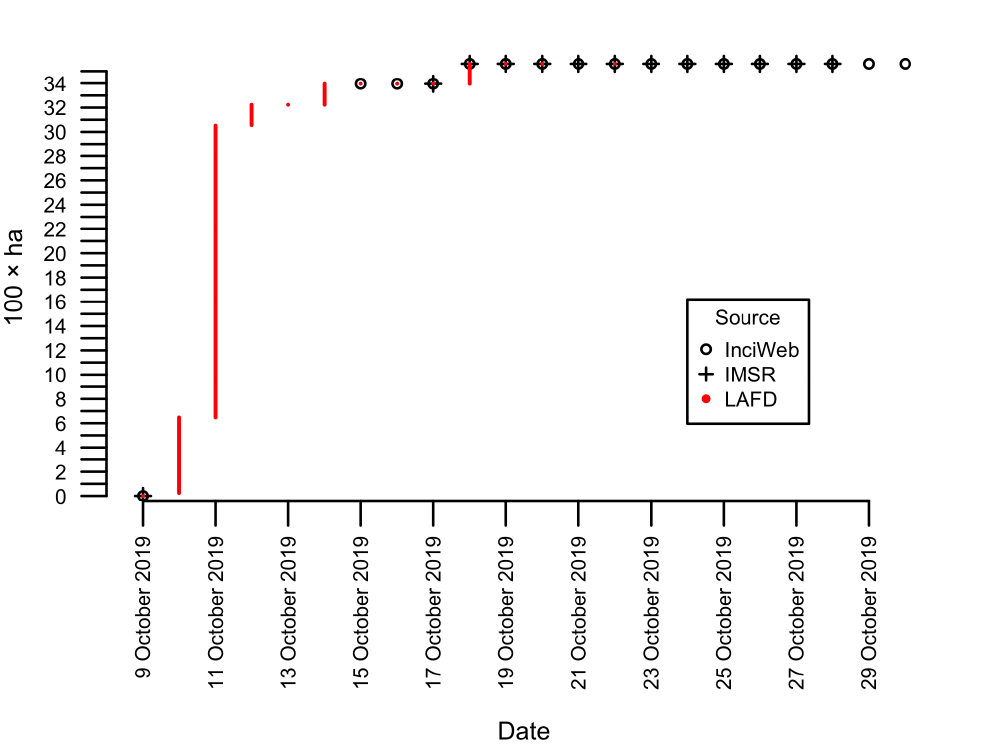
Figure 2. Composite burned area time series from three data sources: InciWeb webscrapes, Incident Situation Management reports (IMSRs), and narratives from the Los Angeles Fire Department